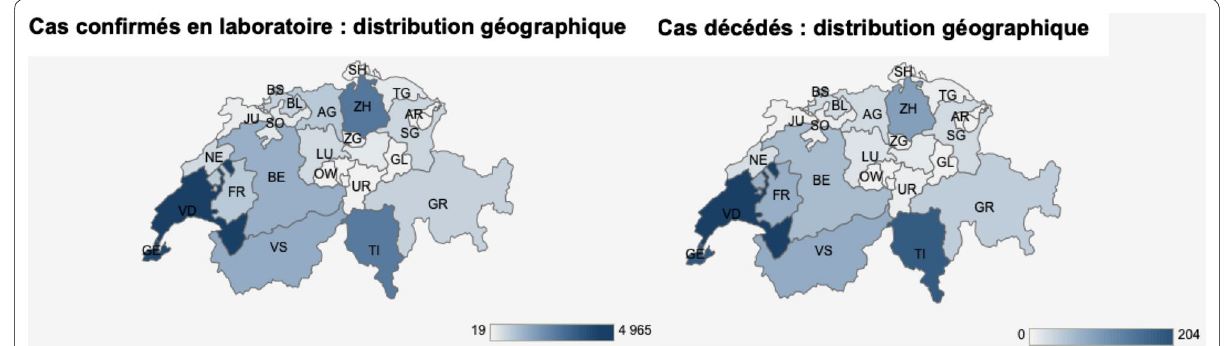
Fig. 3 COVID‑19 rates in Switzerland (Office fédéral de la santé publique). Cas confirmés en laboratoire (laboratory confirmed cases), distribution géographique (geographical distibution), cas décédés (death